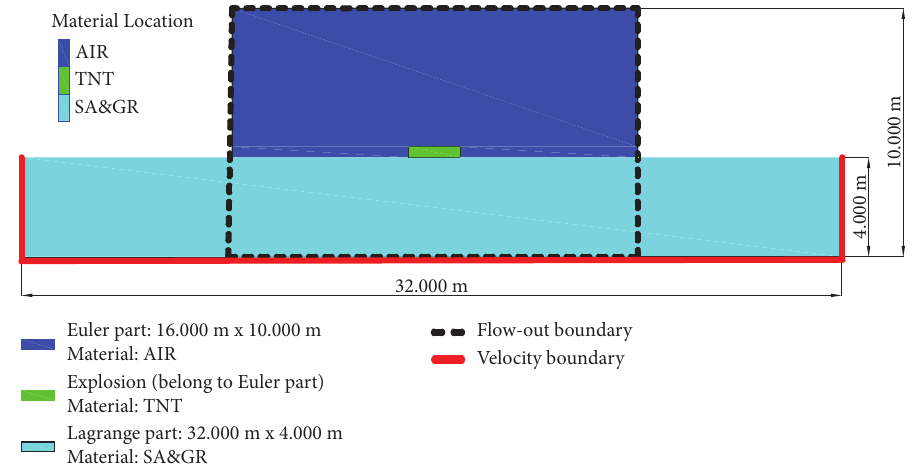
Figure 5: Geometrical model and boundary conditions. Table 2: Material parameters of air. Table 3: Material parameters of TNT